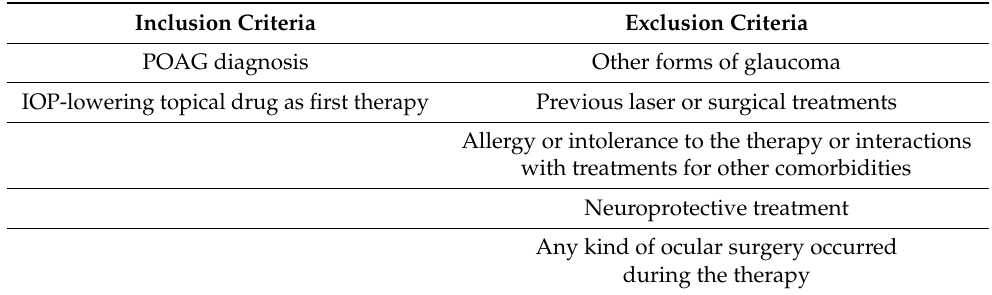
Table 2. Eligibility criteria of